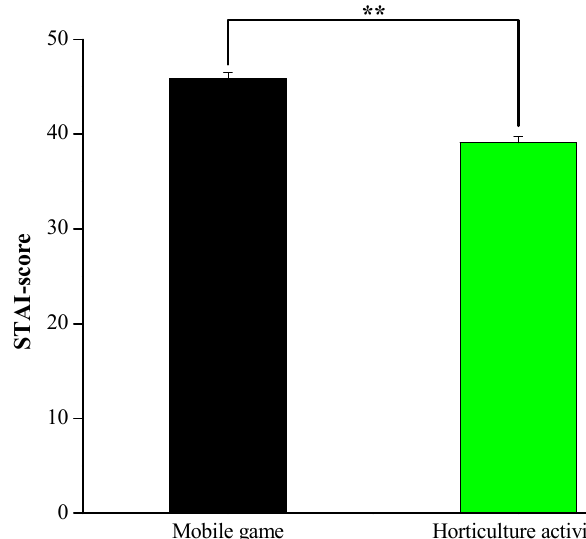
Figure 7. Comparison of participants’ State–Trait Anxiety Inventory (STAI) scores between the two activities. n = 26, mean ± standard error. ** p < 0.01, determined by the Wilcoxon signed-rank test.